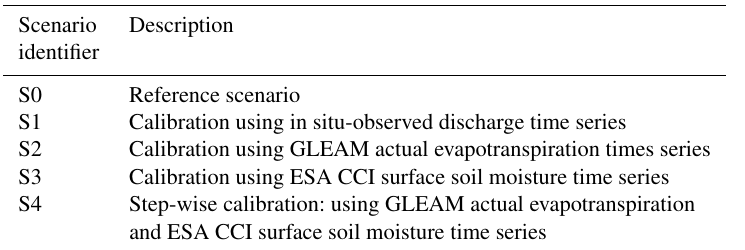
Table 2. Calibration